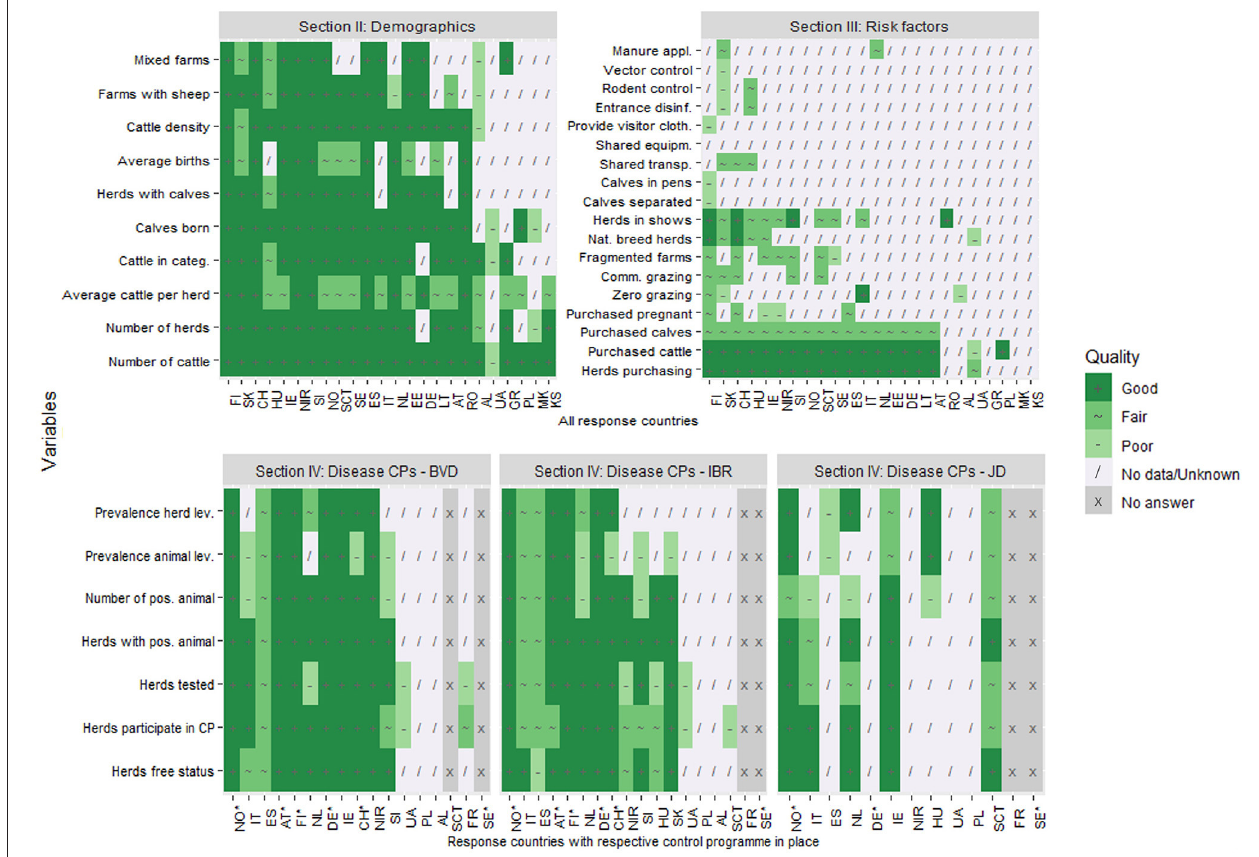
FIGURE 4 | The overall quality of data relevant for estimating probability of freedom from infection in cattle in an online questionnaire study among 24 European countries. The answers are presented by country and variable. *free from disease status. FI, Finland; SK, Slovakia; CH, Switzerland; HU, Hungary; IE, Ireland; NIR, Northern Ireland (UK); SI, Slovenia; NO, Norway; SCT, Scotland (UK); SE, Sweden; ES, Spain; IT, Italy; NL, Netherlands; EE, Estonia; DE, Germany; LT, Lithuania; AT, Austria; RO, Romania; AL, Albania; UA, Ukraine; GR, Greece; PL, Poland; MK, North Macedonia; KS,